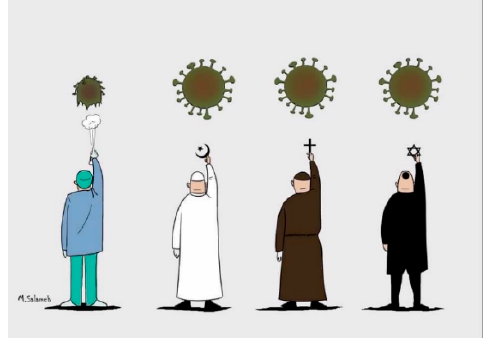
Figure 4. © Salameh. Figure 4. ©